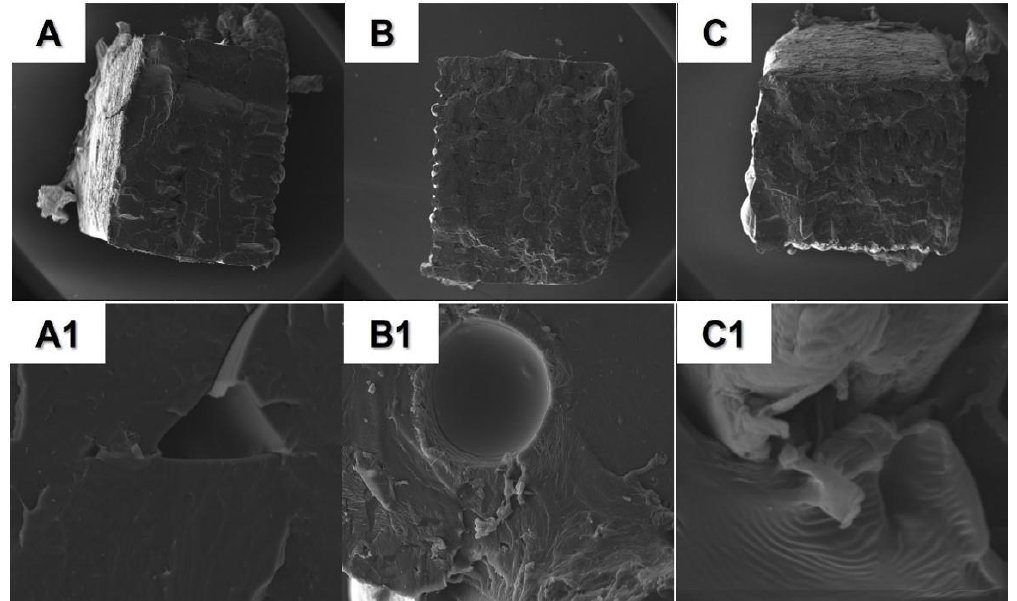
Figure 5. SEM images of PLA/coffee grounds composite 3D printing products with different coffee grounds additions: ( A , A1 ) PLA composite 3D printing products; ( B , B1 ) PLA/3% coffee grounds composite 3D printing products; ( C , C1 ) PLA/7% coffee grounds composite 3D printing products.